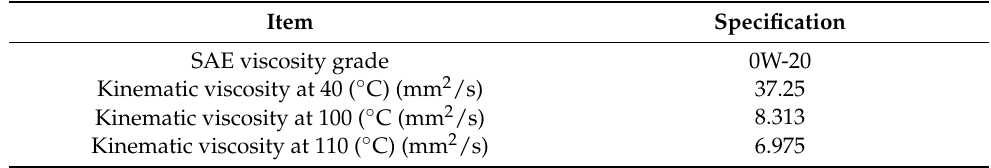
Table 2. Kinematic viscosity of lubricating oil at various temperatures.